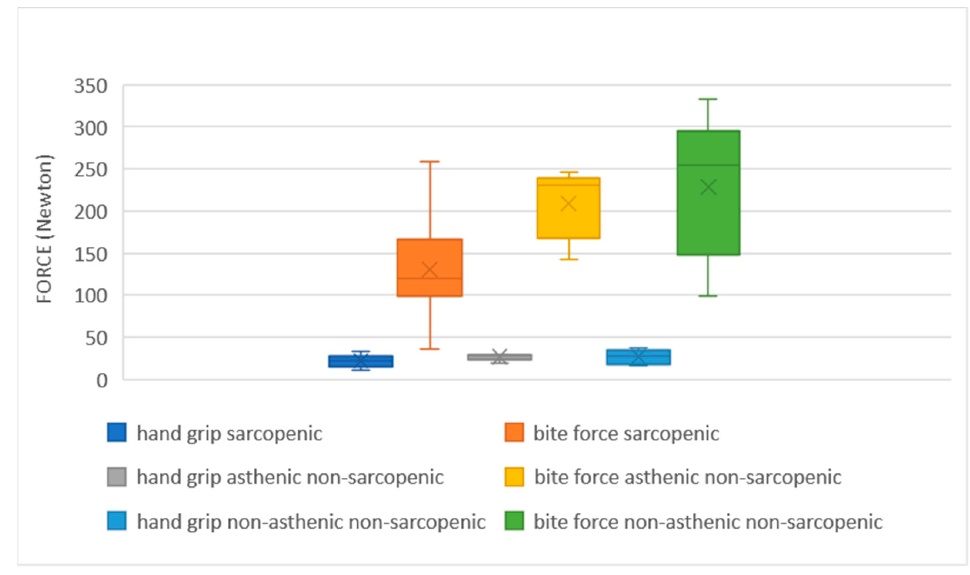
Figure 7. Comparison between hand-grip force and bite force for the three groups of patients.